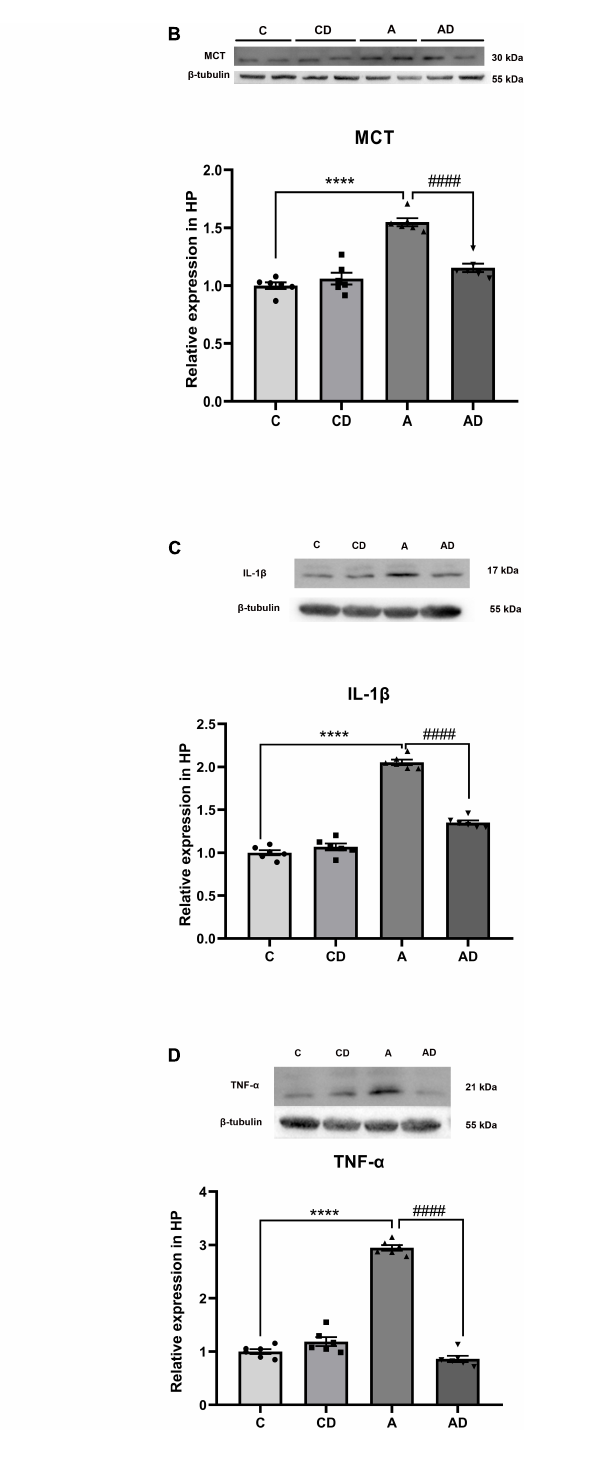
FIGURE4 Effects of Disodium cromoglycate (DSCG) and general anesthesia (GA) on mast cells (MCs) degranulation and neuroinflammation in hippocampus. (A) Representative images of MCs in hippocampal CA1 region. Black arrows represent enlarged MCs. (B) Representative western blot images and graphic presentation of mast cell tryptase (MCT) protein abundance. (C) Representative western blot images and graphic presentation of interleukin (IL)-1 β protein abundance. (D) Representative western blot images and graphic presentation of tumor necrosis factor-alpha (TNF- α ) protein abundance. Results are median ± S.E.M ( n = 6) with the presence of individual animal data in the bar graphs. Results were analyzed by one-way analysis of variance (ANOVA) followed by the Tukey’s test. **** P < 0.0001 compared with C group. #### P < 0.0001 compared with A